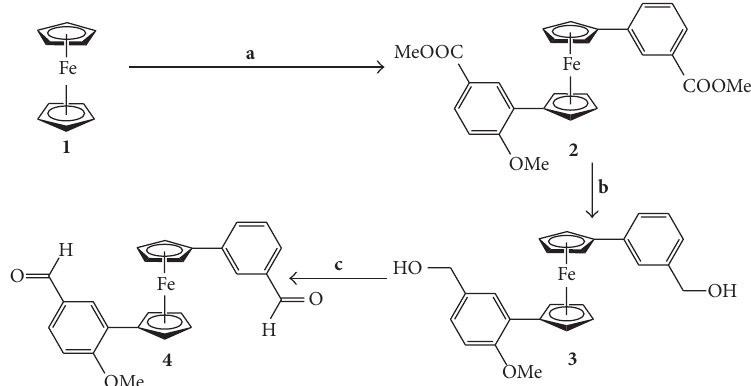
Scheme 1: Synthesis procedure of ferrocene monomer 4 . Reagents and conditions: a (i) diazonium salt of methyl 3-amino-4- methoxybenzoate, AcOH (ii) diazonium salt of methyl 3-aminobenzoate; b LAH, EtOH, r.t.; c MnO